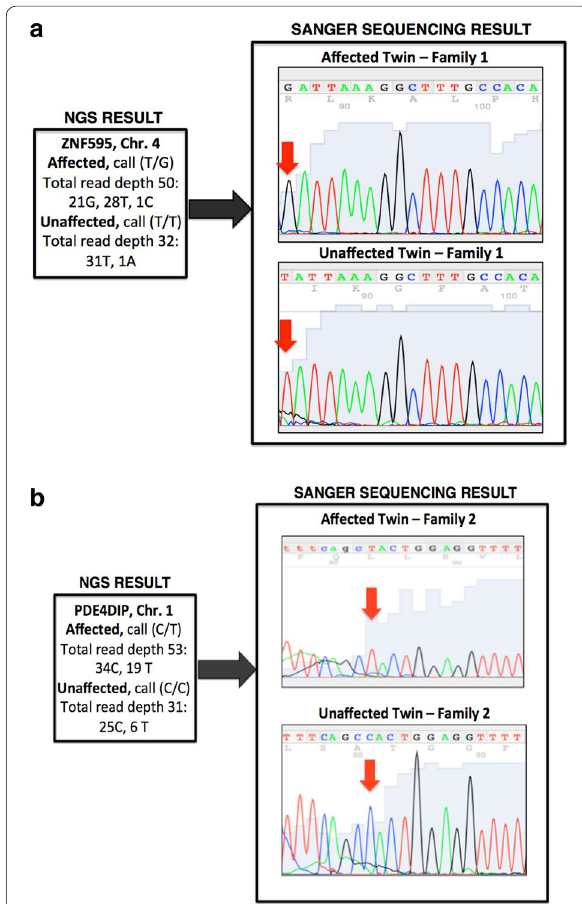
Fig. 5 a Confirmed variant between monozygotic twins in family 1 in the 4th exon of the ZNF595 gene. This variant changes isoleucine to serine. b Confirmed variant between monozygotic twins in family 2 in the 13th exon of the PDE4DIP gene. This variant changes Trypto- phan to a premature stop codon